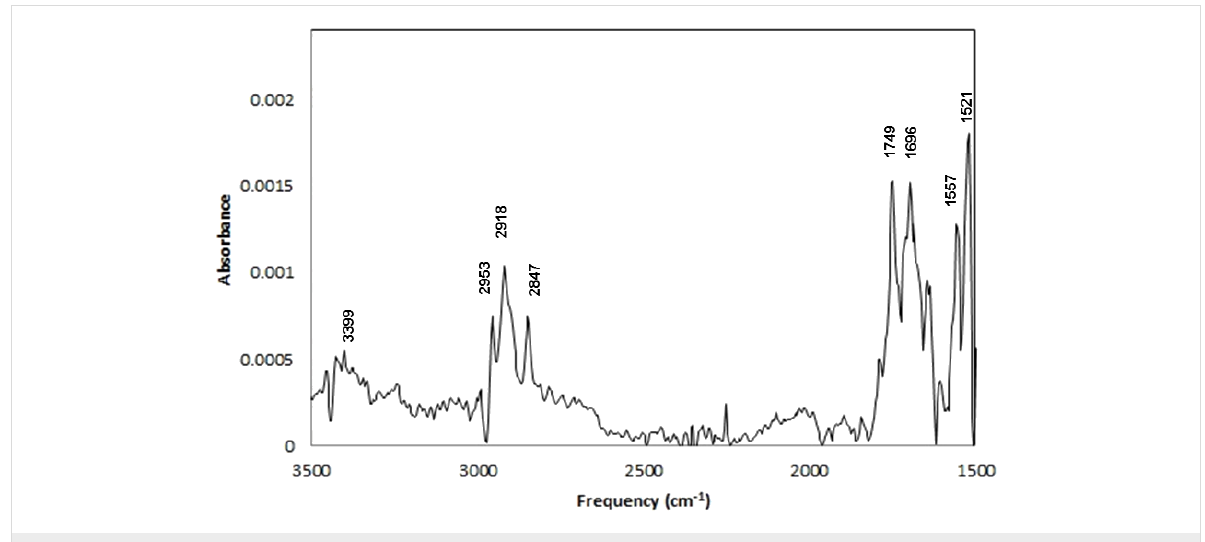
Figure 7: IRRAS Spectrum of Au–NHBoc.